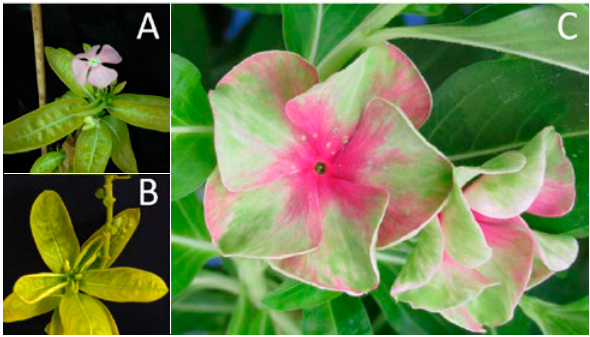
Figure 6. Symptoms in periwinkle after Bergallia valdiviana trans- mission; A), B) VC60B, leaf deformation and severe yellowing; C) VC62B, flowers showing